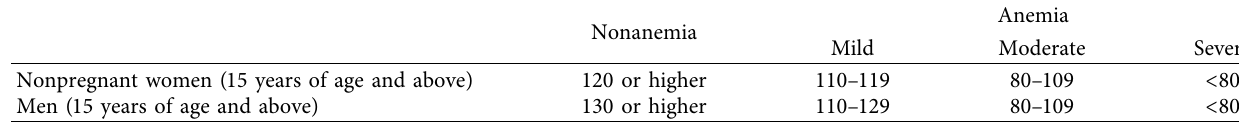
Table 1: Hemoglobin levels for stratification into mild, moderate, and severe anemia [14].